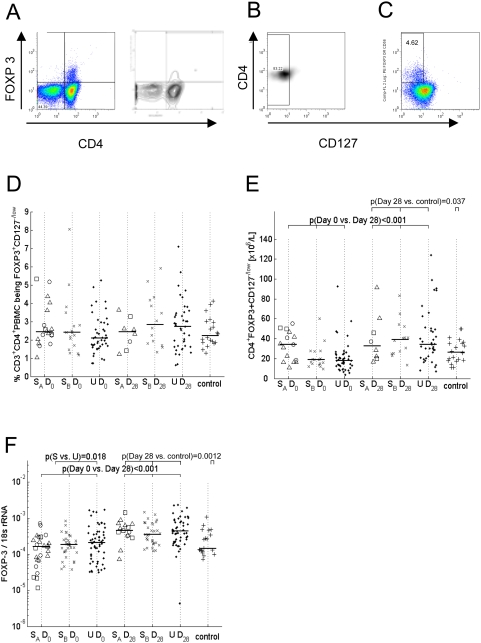
Similar number and proportion of Tregs in uncomplicated and severe disease, increasing during convalescence.Tregs were defined as CD3+CD4+PBMC being FOXP3+and CD127−/low. (A) CD3+ viable PBMC were displayed according to CD4 and FOXP3 and FOXP3 positive cells were defined on contour display as cells above the 90% contour level. (B) CD3+CD4+FOXP3+ PBMC were displayed according to CD127 expression to define the CD127 low cut off. (C) both gates were applied to CD3+CD4+ PBMC. (D) The percentage of Tregs for severe cases is shown for the subgroup (SA) comprising cases with CM (triangles), SA (squares) and SRD (circles), for the subgroup with severe prostration (SB), and for uncomplicated cases (U) for days 0 (D0) and 28 (D28) and compared to healthy controls of a similar age range recruited from the study area at the same time. (E) absolute numbers of cells expressing a Treg phenotype. (F) FOXP3 mRNA levels expressed as a ratio to the house keeping gene 18s rRNA. Dots represent individual data; bars represent the median. P-values are derived from the random effects linear regression model, adjusting for age, sex, duration of symptoms and numbers of clones isolated.